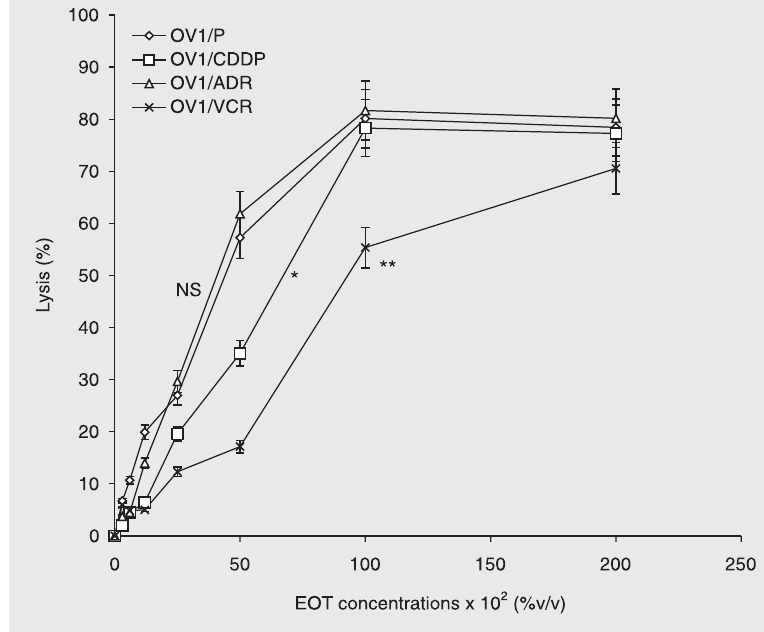
Figure 2. In vitro cytotoxic effect of the essential oil of Thymus broussonettii (EOT) on tumor cell lines. Cells (10 5 /mL) were treated with increasing concentrations of EOT. After 48 h of incubation, cell lysis was determined as described in Material and Methods. Data are the mean ± SEM of three independent experiments. NS = non-significant. *P < 0.05 and **P < 0.01 compared to control